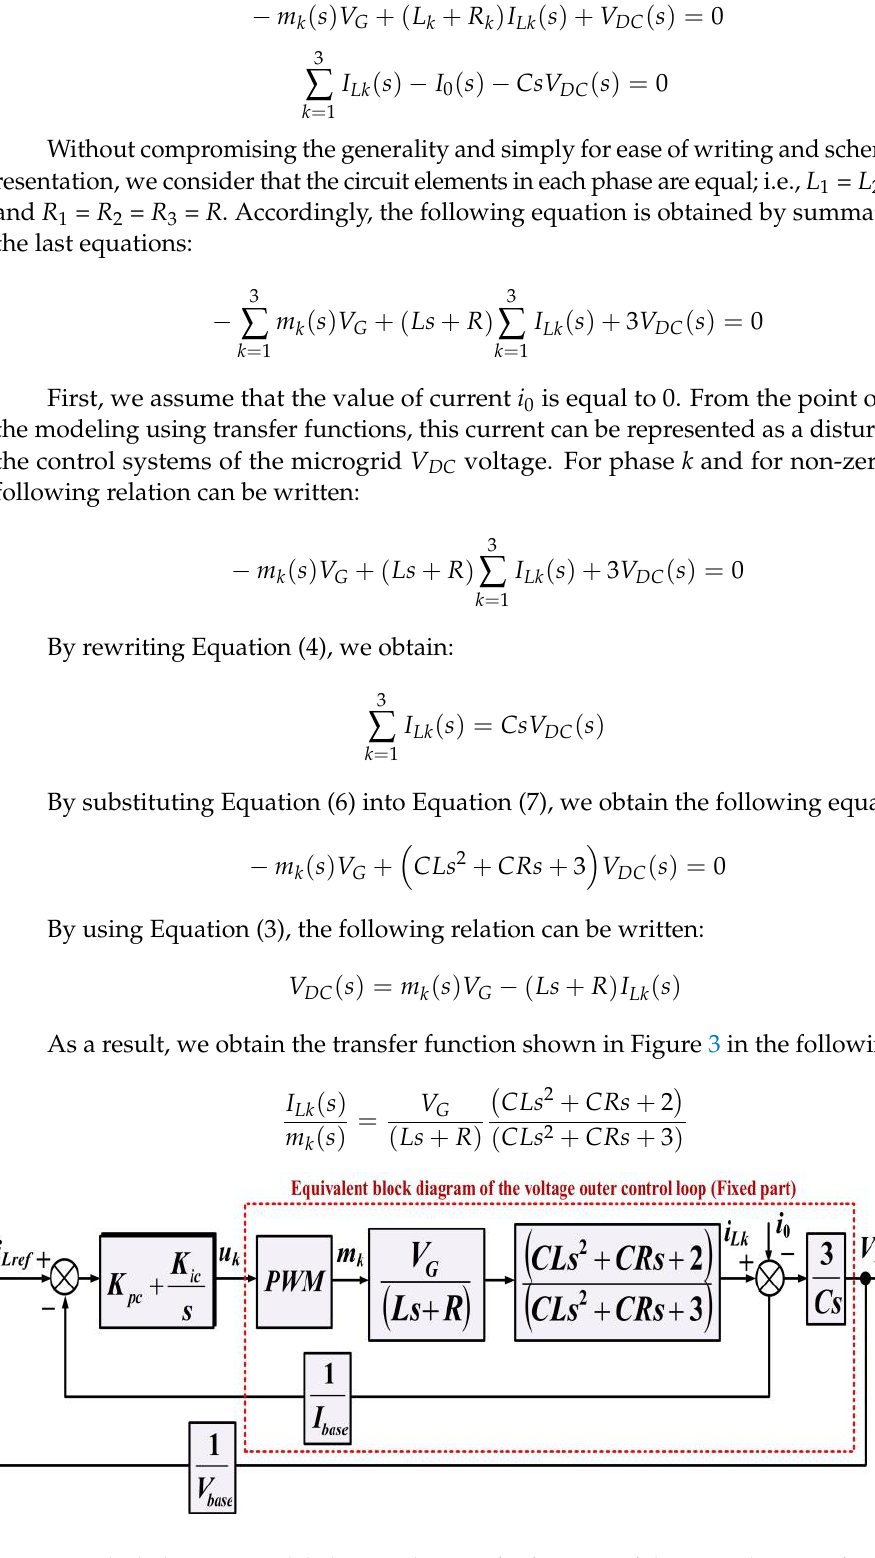
Figure 3. Block diagram modeled using the transfer function of the control system for the power electronic converter.